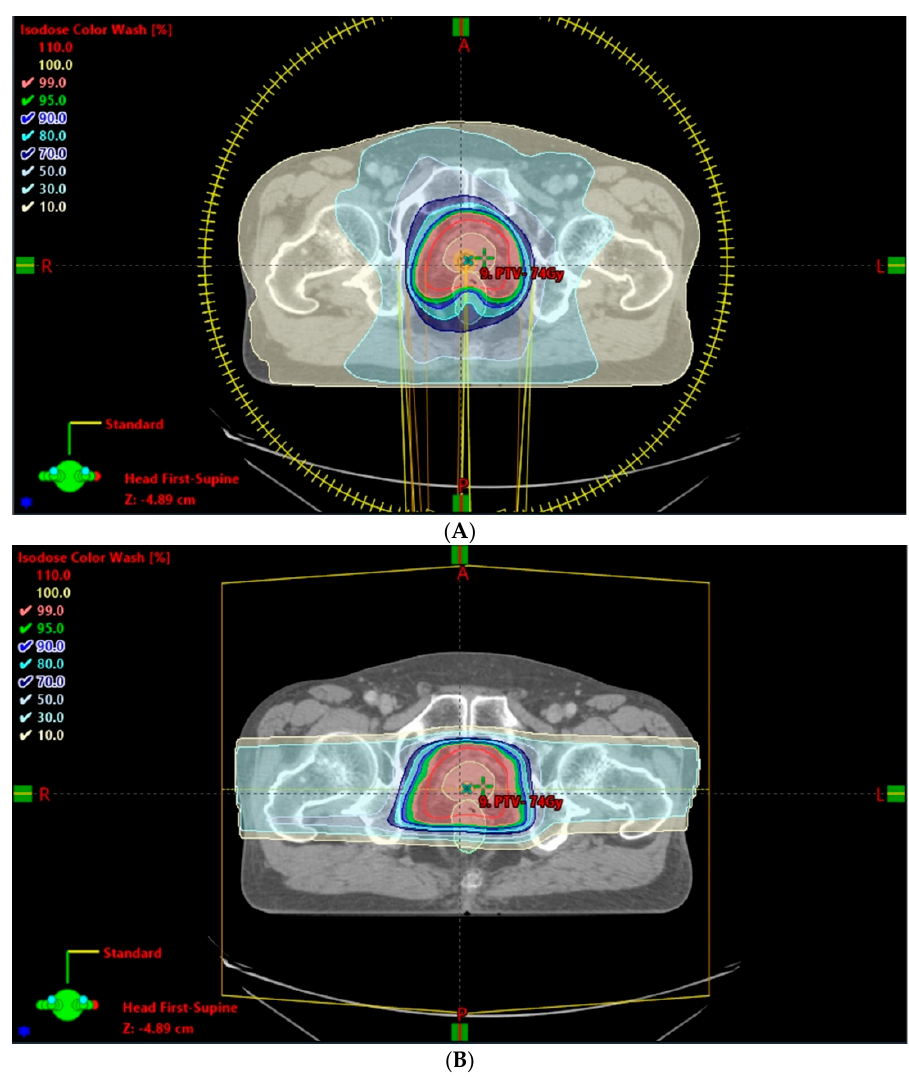
Figure 1. Integral dose comparison of volumetric modulated RapidArc therapy (VMAT)-full rotation ( A ) and photon therapy (PT)-bilateral ( B ) in prostate treatment plans. The most significant differences were in the 10% and 30% isodose distributions of the 78-Gy prescription.